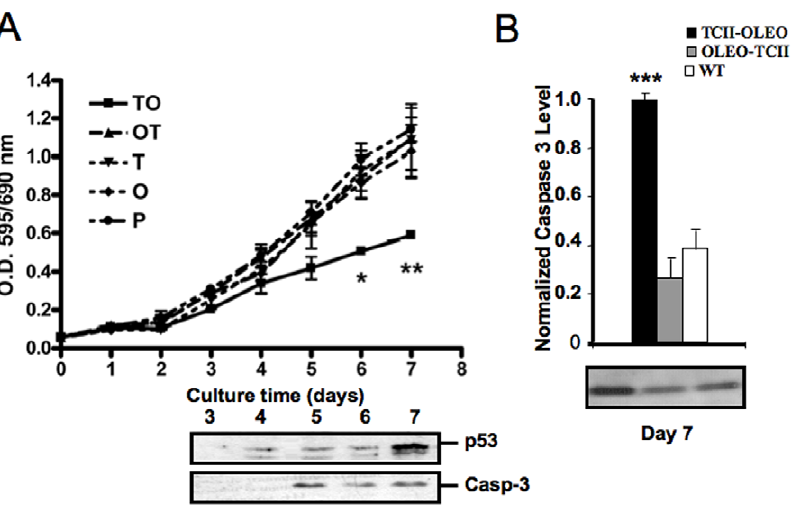
Figure 2. Viability and apoptosis of N1E-115 cells stably transfected with different plasmids. The plasmids were pCMV-TCII-OLEO coding for transcobalamin-oleosin (TCII-OLEO), pCMV-OLEO-TCII coding for oleosin-transcobalamin (OLEO-TCII), pCMV-TCII coding for transcobalamin II (TCII), pCMV-OLEO coding for oleosin (OLEO), and pCDNA3. A: Cell viability and apoptosis among growth delay in proliferated state was monitored by the absorbance of formazan dye resulting from enzymatic metabolism of MTT by the mitochondrial dehydrogenase. The no reagent blank was MTT alone (0.5 mg/mL in culture medium). Western blot analysis of the temporal course of p53 in cells transfected with pCMV-TCII-OLEO was made by using a mouse anti-p53 antibody and a mouse anti-actin antibody, which were revealed with a goat anti-mouse IgG coupled to peroxidase. Cleaved Caspase-3 was identified by a rabbit anti-caspase-3 polyclonal antibody and a donkey anti-rabbit secondary antibody (labeled with peroxidase). B: Western blotting of cleaved Caspase-3 at Day 7 of proliferate state. The mean 6 S.E.M. were obtained from three independent experiments made in triplicate. Two-way ANOVA and Bonferoni post-test analyzed statistical differences from the control groups. *, P , 0.05; **, P , 0.01; ***, P , 0.001.